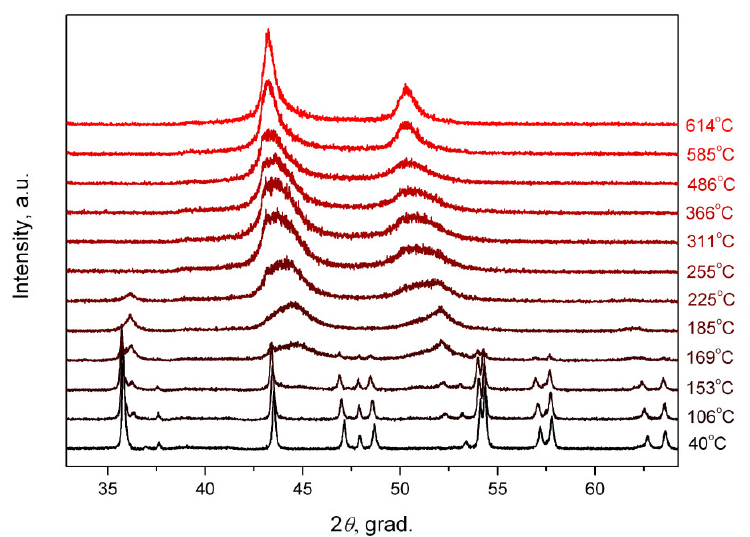
Figure 9. In situ X-ray diffraction of Ag 2 [PtCl 6 ] products thermolysis in a hydrogen atmosphere ( λ = 1.720 Å).